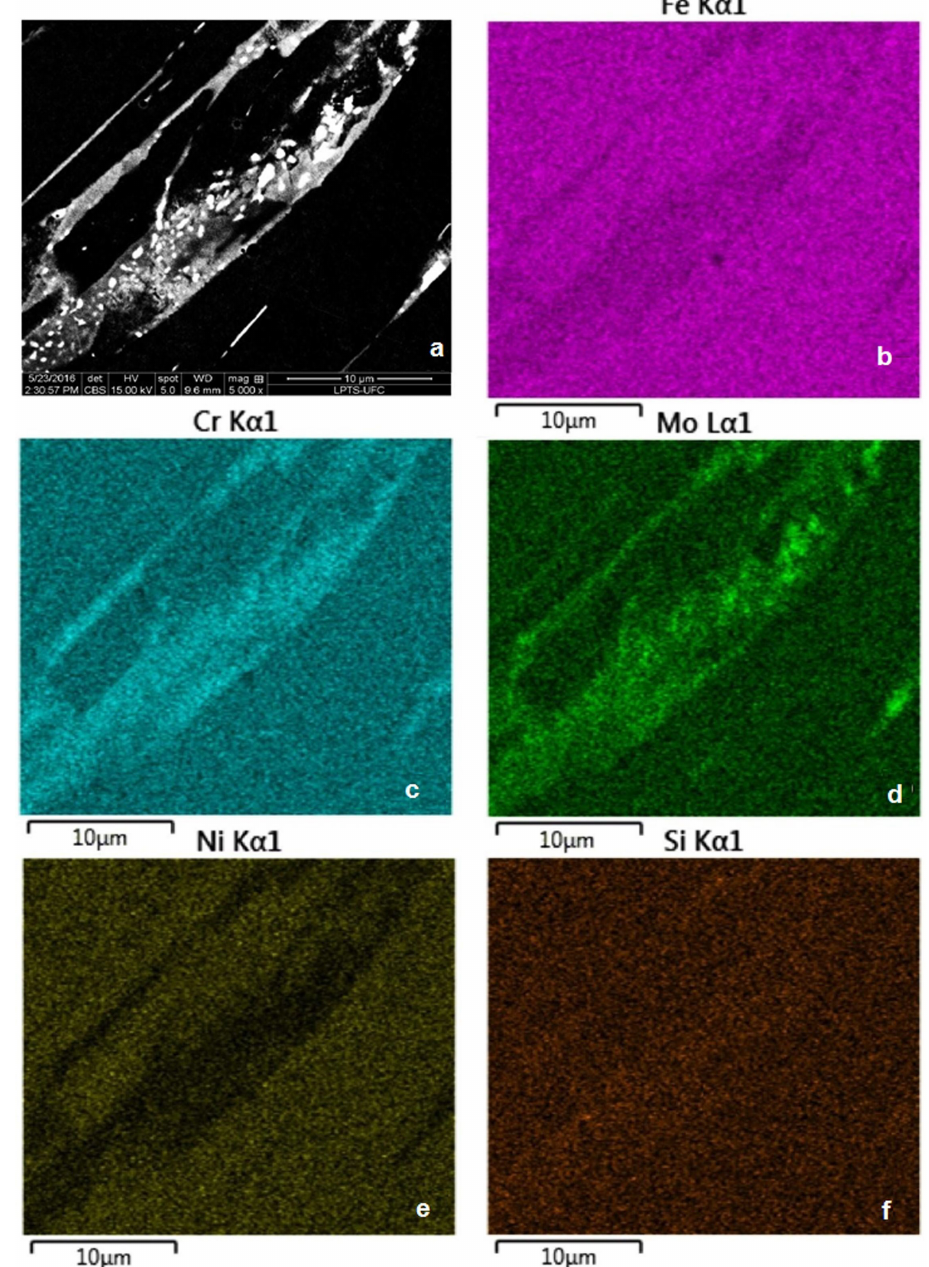
Figure 9. EDS mapping in the fusion zone using heat input of 8 kJ/cm and aged for100